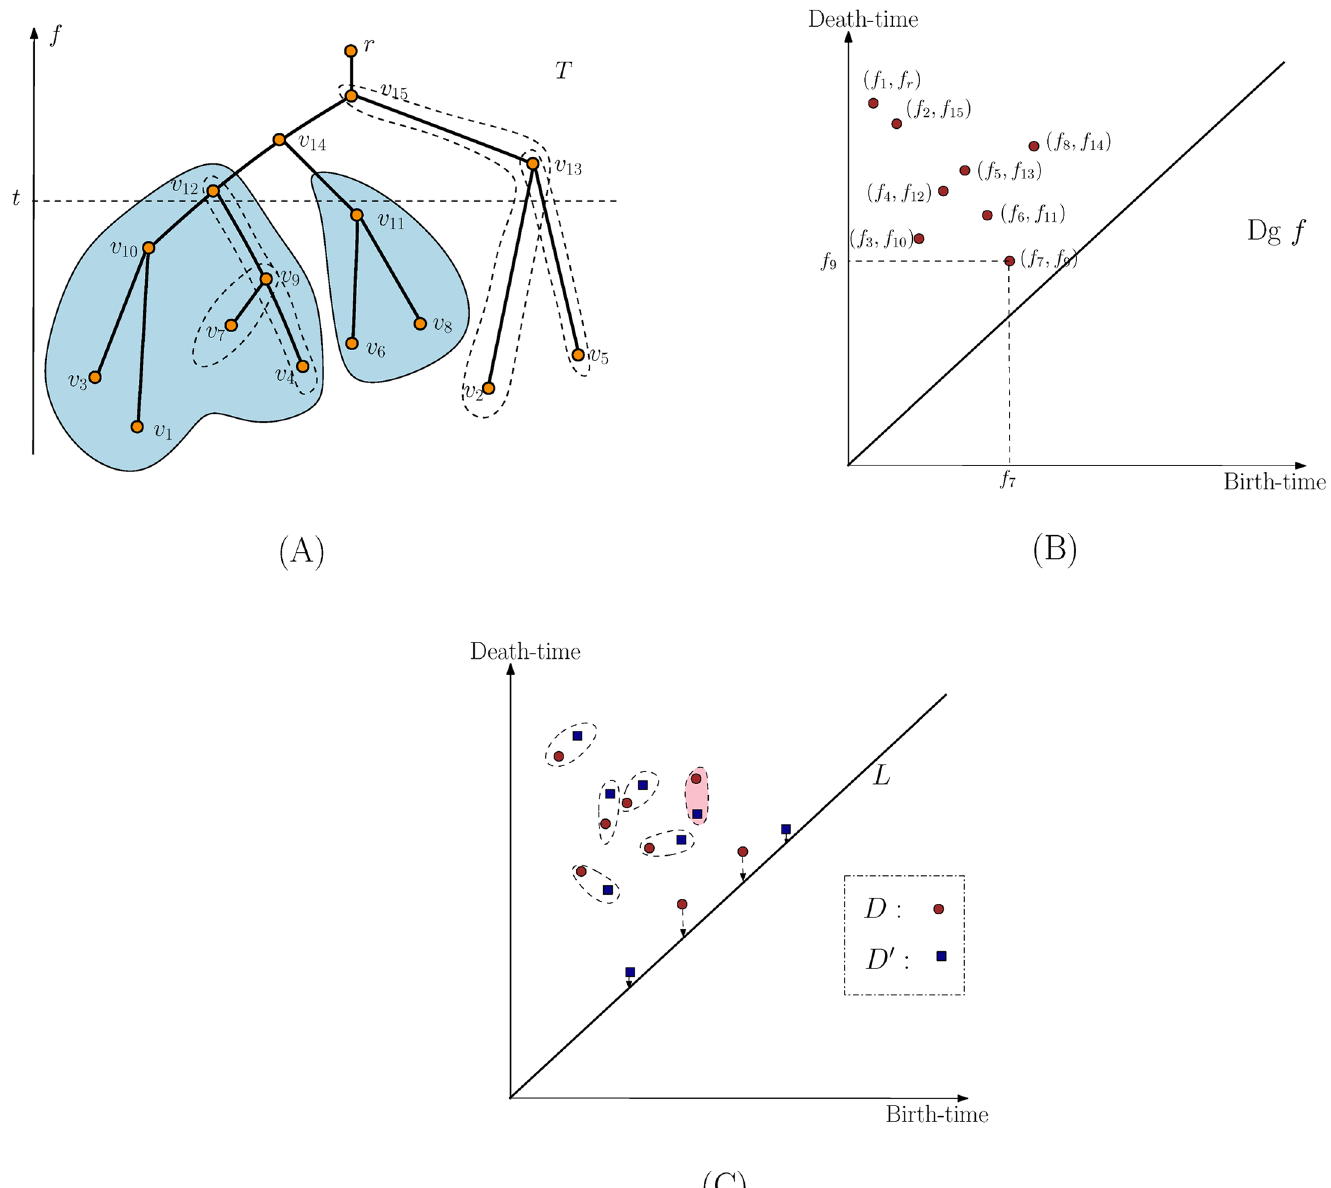
Fig 2. Examples of persistence diagrams. (A). We plot the tree T so that the height of a point is its f value. The sublevelset T t is the portion of T lying belowthe horizontal dashed line corresponding to { x 2 | T | | f ( x ) = t }. Considerwhat happens when the filtration index α passes the vertex v 14 . At this time the left and right subtrees (shaded)merge at v 14 . These subtrees were originallygeneratedat m 1 = v 1 and m 2 = v 6 respectively. Since the right subtree was born at the later time f ( v 6 ) = f 6 , this event correspondsto the “death” of the right subtree (with a death time f ( v 14 ) = f 14 ). This gives rise to a persistence point ( f ( v 6 ), f ( v 14 )) = ( f 6 , f 14 ) in the persistencediagramin (B). In (B), for simplicity, we set f i : = f ( v i ). We mark some pairs of tree nodesgenerating persistence points in (A) via dashed closed curves, such as ( v 7 , v 9 ) and ( v 4 , v 12 ). In (C), red and blue points correspond to persistencepoints in two persistence diagrams D and D 0 , respectively. An exampleof a correspondence is given, with points matched to diagonalconsidered to be noisy points.